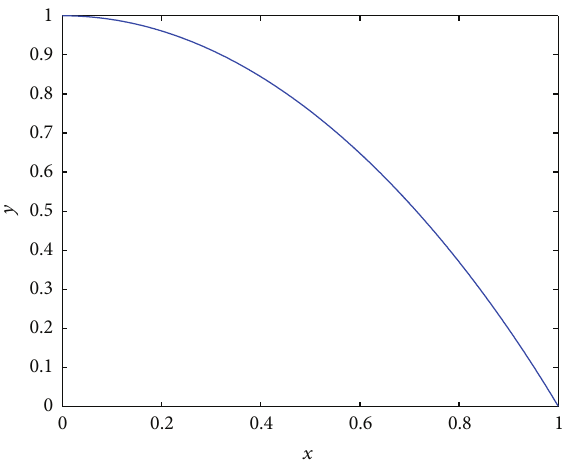
Figure 4: Solution to the nonsymmetric scheme for 𝑛 = 100 . In [4] the value assigned to 𝛽 is ℎ 3 𝑦 follows the same procedure with the value for 𝛽 defined by (54) replacing the value for 𝛽 in [4]. The amplification factor,